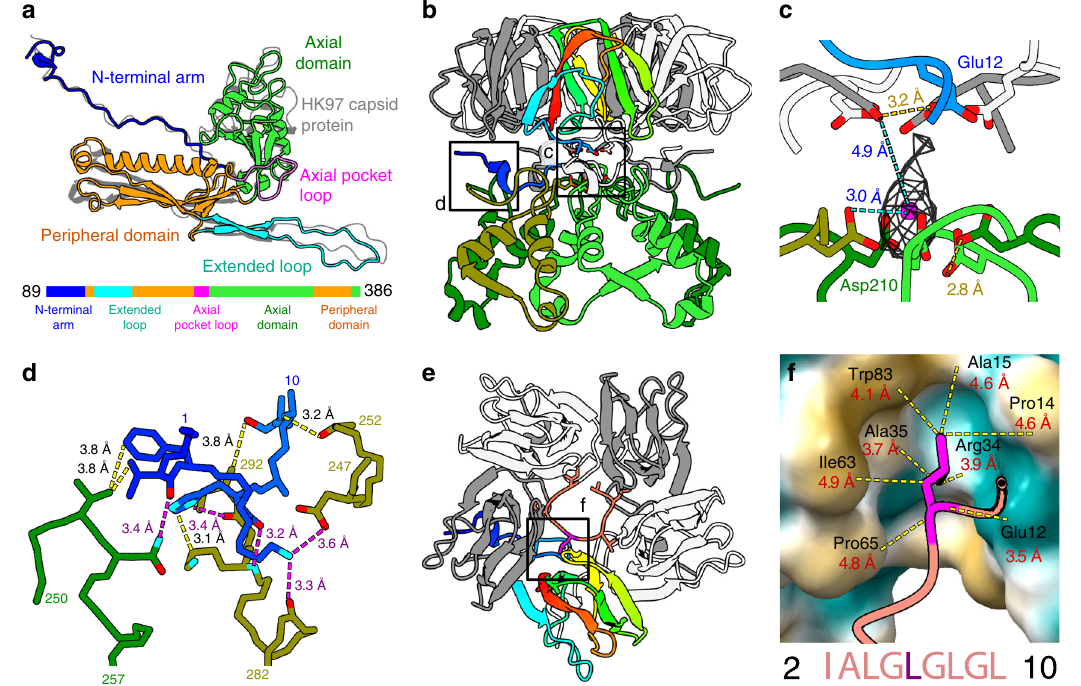
Fig. 2 Structure of the major capsid protein and head fi bers of RcGTA. a The major capsid protein of RcGTA has the HK97 fold. The structure of the capsid protein of phage HK97 (PDB 1OHG, shown in gray) is superimposed onto that of RcGTA. The domain organization of the protein is shown in the sequence diagram at the bottom of the panel. b The interaction of base proteins of the head spike with axial domains of major capsid proteins. One subunit of the base protein is rainbow-colored from the N-terminus in blue to the C-terminus in red; the other four subunits are shown in gray and white. The axial domains of the fi ve major capsid proteins are differentiated by shades of green. Details highlighted with black squares are shown in higher magni fi cation in panels c and d . c Coordination of a putative cation by sidechains of Asp210 of major capsid proteins and Glu12 of base proteins strengthens the attachment of base proteins to the RcGTA head. The sidechains of residues interacting with the putative cation are shown in stick representation. Proteins are colored as in b . d Detail of the interaction of the N-terminus of the base protein (blue) with two subunits of major capsid proteins differentiated by being colored in olive and green. Selected interatomic distances are indicated by dashed yellow lines, salt bridges are highlighted with magenta lines. e Top view of a pentamer of base proteins with attached N-terminus of head fi ber protein, shown in salmon. The isoleucine and repetition of the leucine residues enable the binding of the head fi ber to the pentamer of head spike base proteins. Detail of the indicated interaction is shown in f . f Interaction of leucine 6 of the head fi ber, shown in magenta, with the hydrophobic pocket of the head fi ber base protein, which is shown as a molecular surface. Yellow indicates a hydrophobic surface and turquoise a charged surface. Distances between selected atoms are indicated. The repetitive sequence from the N-terminus of the head fi ber protein is shown at the bottom of the (Fig. 2e). The repeated (iso)leucines enable the peptide to bind to hydrophobic pockets of fi ve base proteins (Fig. 2EF). The rest of the head fi ber protein is fl exible, as demonstrated in two- dimensional class averages of the head spikes (Fig. 1d, Supple- mentary Fig. 8). It was shown that RcGTA head fi bers enable the attachment of particles to the polysaccharide capsule of R. capsu- latus 29 . The fl exibility of the head fi bers may facilitate the poly- valent binding of RcGTA to the capsule.